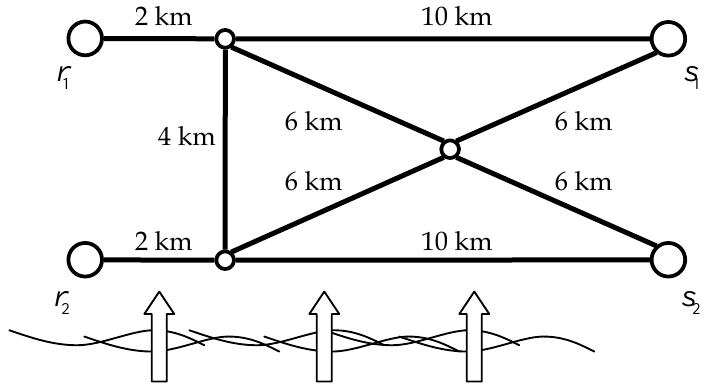
Figure 3. Test network and disaster scenario